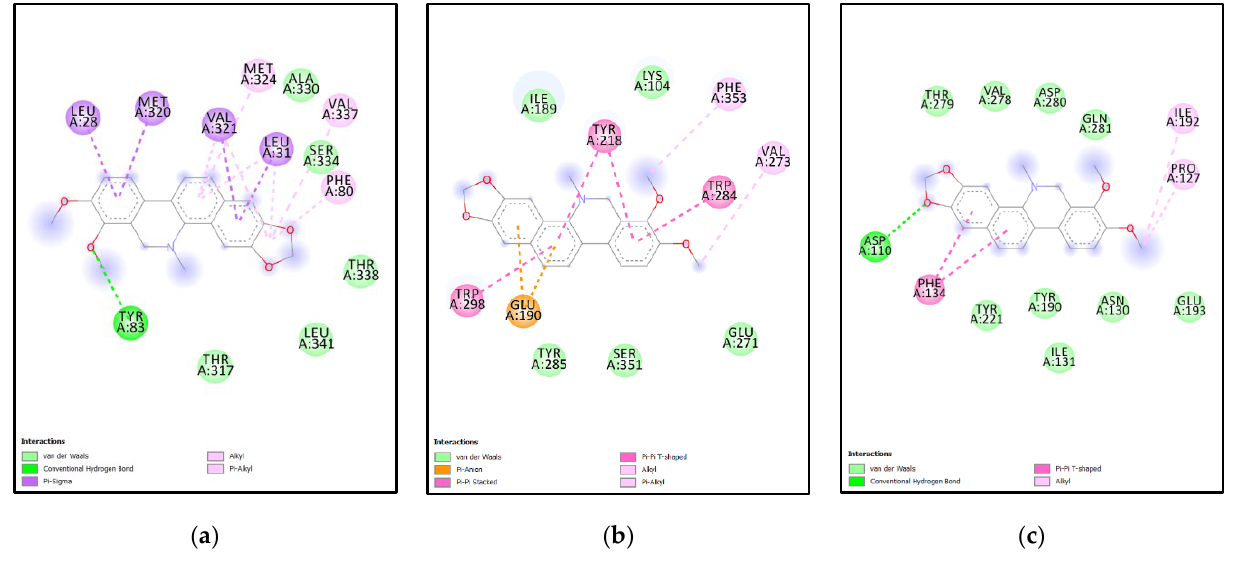
Figure 10. Ligplot showing amino acid residues involved in Chelerythrine -protein interaction for ( a ) Yeast-Chelerythrine interacting amino acid residues ( b ) XP-Chelerythrine interacting amino acid residues ( c ) XM-Chelerythrine interacting amino acid residues.